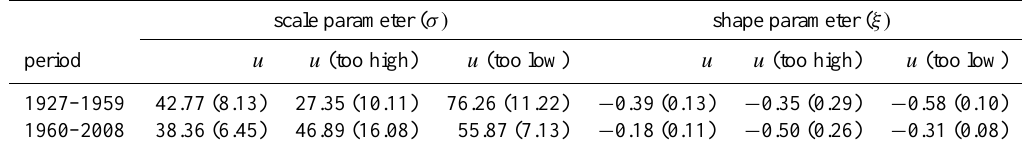
Table 1. Scale ( σ ) and shape ( ξ ) parameters for models with u selected (410DU, 400DU), u too high (445DU, 443DU) and u too low